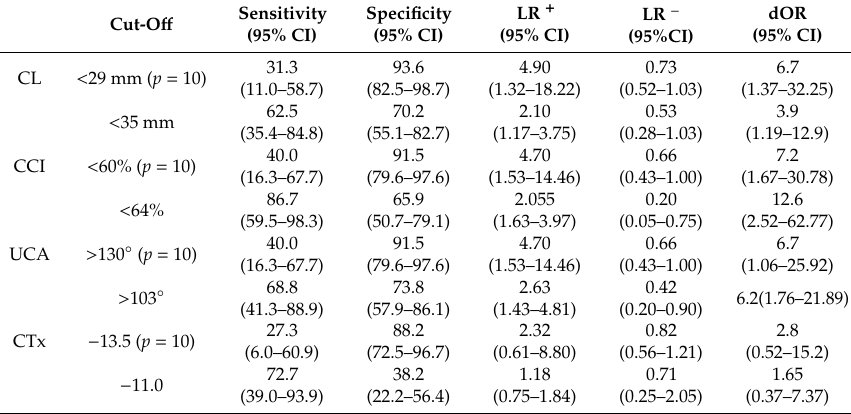
Table 2. Discriminative performance of the UCL, CCI, UCA, and CTx measurements with regard to predicting spontaneous preterm birth < 34 + 0 weeks, with optimal cut-o ff based on the receiver operating characteristic curve given.